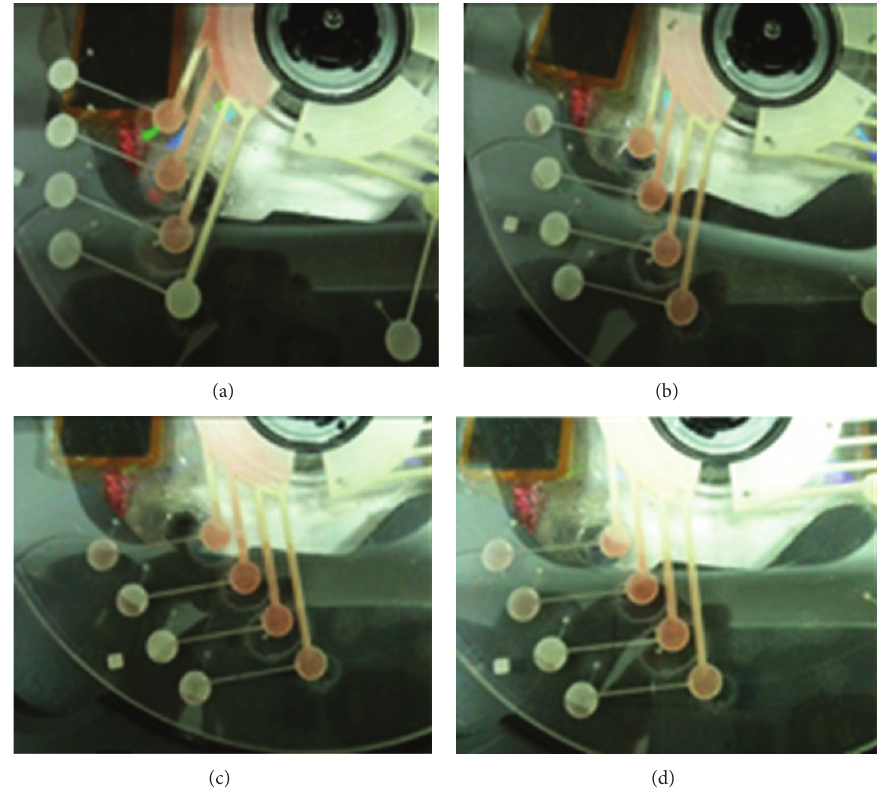
Figure 10: Fluid flows for rotation speeds of (a) 660, (b) 1500, (c) 1600, and (d) 1700rev/sec. The rotation was in the clockwise direction for panels (a)-(b) and in the counterclockwise direction for panels (c) and (d).